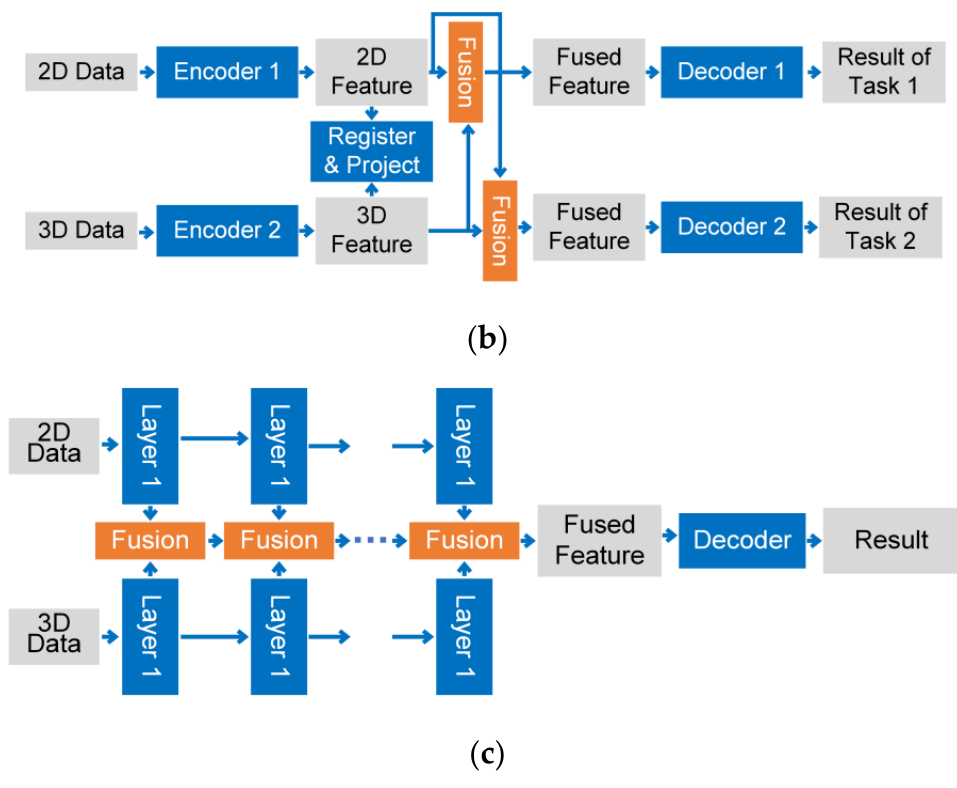
Figure 11. The general structure of feature-based fusion strategy. ( a ) One-stage feature-based fusion strategy; ( b ) multi-stage fusion strategy; ( c ) cross-level fusion strategy.